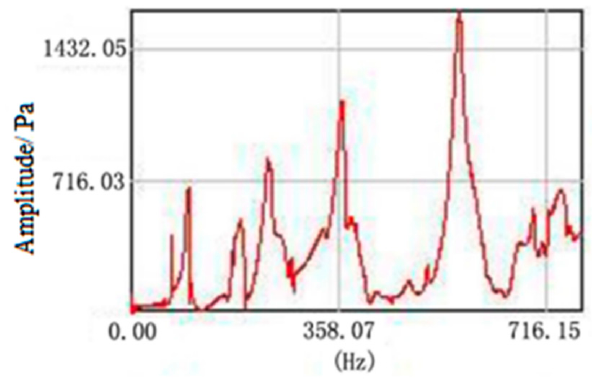
Figure 5. Response output of node C21.